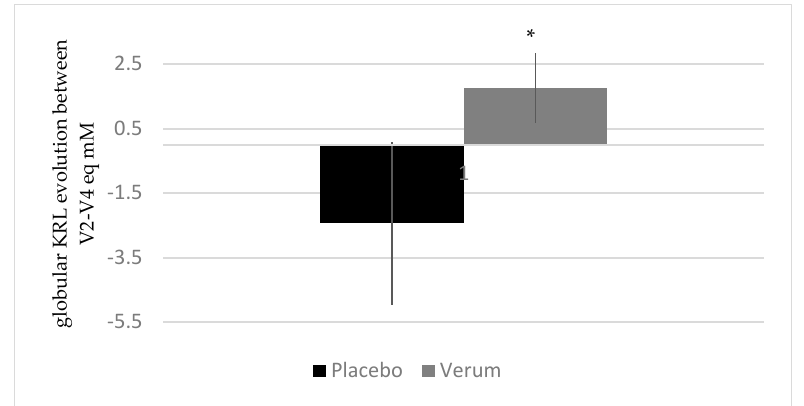
Figure 6. Influence of melon concentrate supplementation on the oxidative defenses. * p < 0.05 effect of the melon concentrate supplementation compared with placebo group.